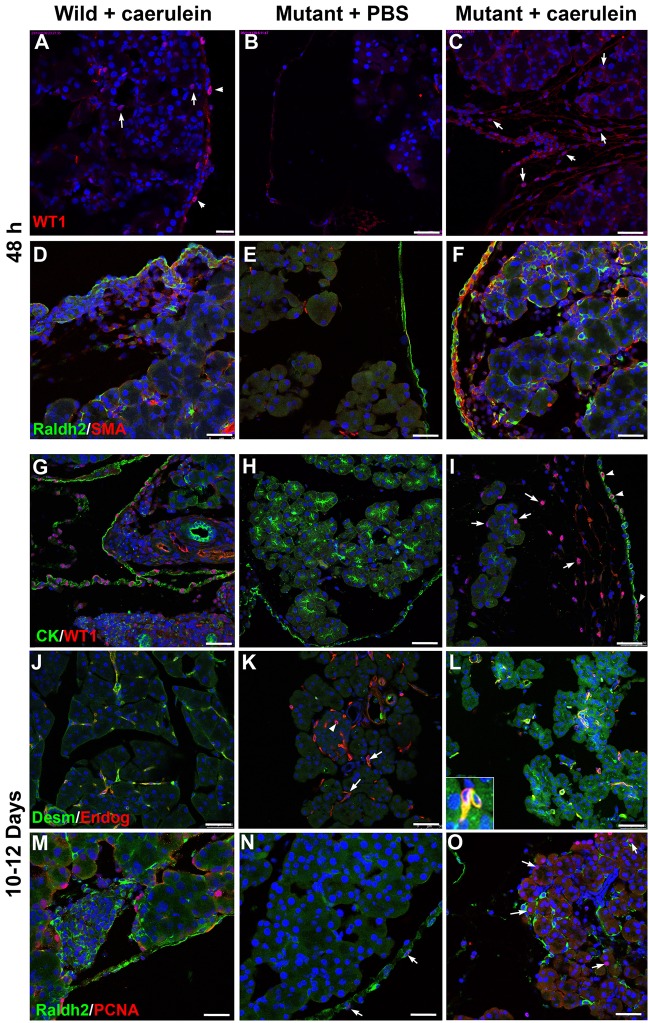
Pancreatic phenotype after systemic deletion of WT1 in the Wt1CreERT2;Wt1flox model and induction of pancreatitis with caerulein.A-F show results obtained after 48 h and G-O represent the pancreas after 10–12 days, when mice have recovered from pancreatitis. A-C. WT1 is expressed in mesothelial and stromal cells of the mouse with pancreatitis (A), it is lacking in mice after deletion of WT1 (B), but it is expressed in stromal cells after induction of pancreatitis (arrows in C). D-F. Markers of pancreatic stellate cell activation (SMC α-actin, RALDH2) are upregulated by induction of pancreatitis, even when WT1 expression has been ablated as shown in F. G-I. WT1 expression persists in mice with WT1 deletion after recovery of pancreatitis (arrows in I), and this expression appears even in some pan-cytokeratin+, mesothelial cells (arrowheads in I). J-L. The number of desmin+ expressing cells (putative stellate cells) increase in the pancreas with WT1 deletion after pancreatitis (arrows in L). These cells lose the desmin immunoreactivity in WT1-deficient mice, but they keep the CD105 expression (arrows in K) even in the islets (arrowhead). M-O. Proliferating cells are abundant in the pancreatic stroma of mice with WT1 deletion after recovery of pancreatitis (arrows in O), but they are very scarce and limited to the mesothelium in mutant mice that have not suffered of pancreatitis (arrows in N). Note the increase in RALDH2 in the mutant mice after recovery of pancreatitis (quantified in S5 Fig). Scale bars: A = 50 μm, B-O = 50 μm.